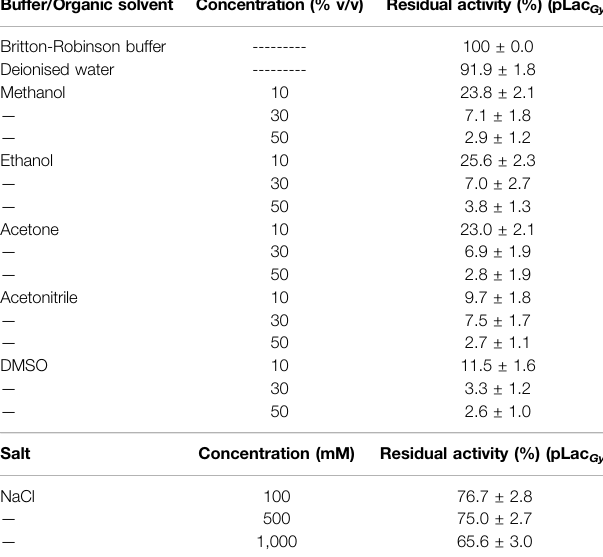
TABLE 1 | Effect of organic solvents and NaCl on the stability of pLac Gy . Residual activitywasmeasuredat60 ° Cinpresenceof1 mMABTSand50 μ MCuCl 2 in 0.04 M Britton-Robinson buffer (pH 5.0) after pre-incubating the enzyme in the test condition for 6 h. The activity of the enzyme without pre-incubation measured at the pH 5.0 at 60 ° C was set at 100%. All experiments were conducted in triplicates and uncertainties represent standard deviations. Buffer/Organic solvent Concentration (% v/v) Residual activity (%) (pLac Gy ) Britton-Robinson buffer